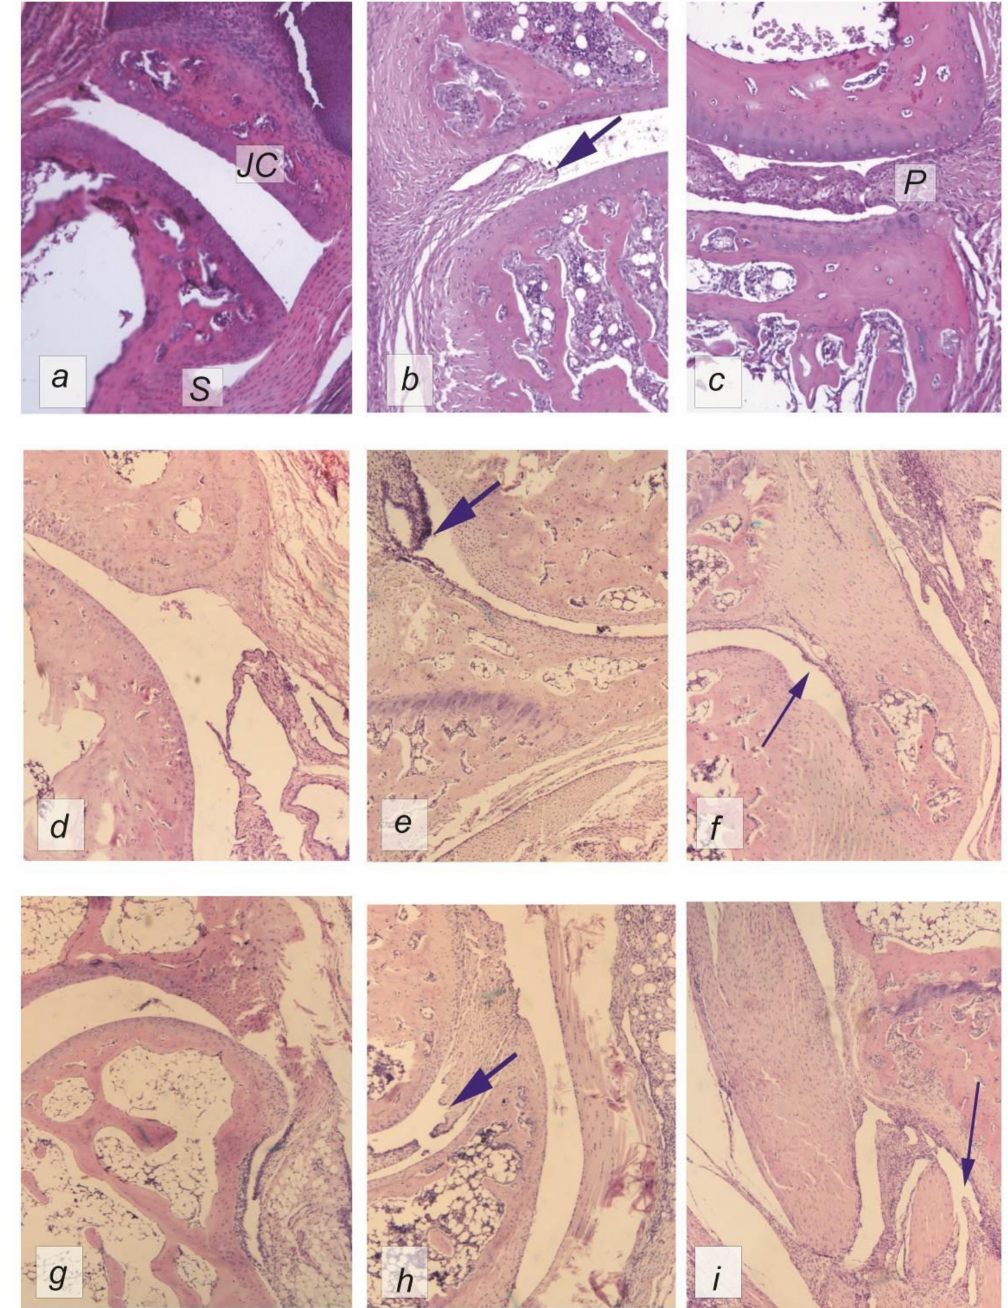
Figure 2. Hematoxylin–eosin-stained rat metatarsophalangeal joints from different periods during the experiment (used 5 × lens); ( a ) sham; ( b , c ) control after 7 and 21 days, respectively; ( d – f ) 7, 14, and 21 days after treatment with Cytos-11, respectively; ( g – i ) 7, 14, and 21 days after treatment with Humira, respectively. Thick arrows indicate destructive changes in the joints and synovial hyperplasia. Thin arrows show the restoration of the normal structure of the synovium. P—pannus, S—synovial membrane, JC—joint